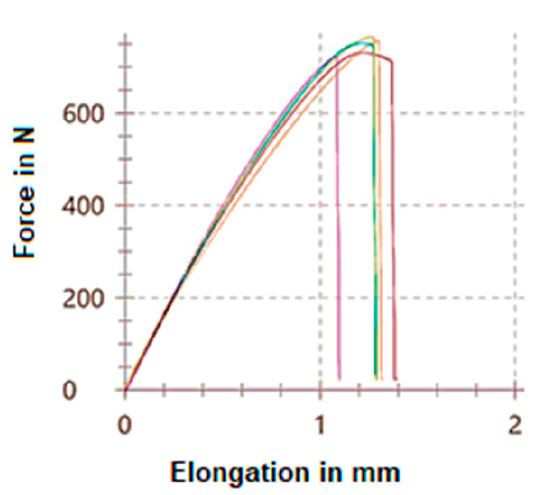
Figure 5. Tensile curves of the vertically orientated test specimens.